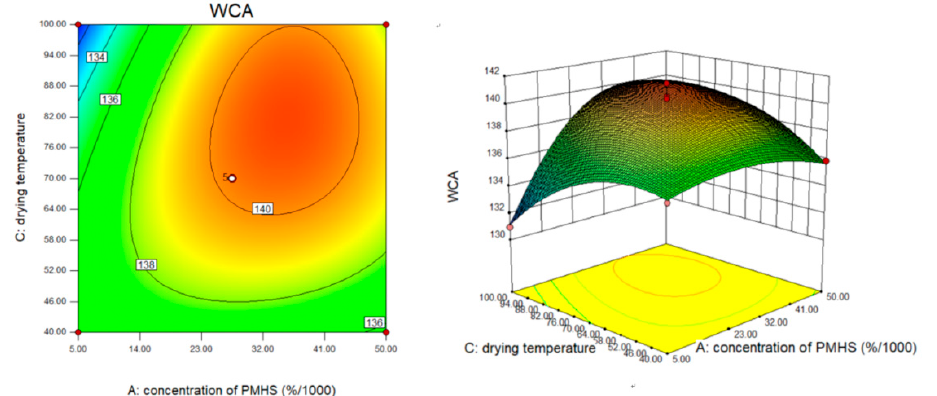
Figure 5. The effect of PMHS concentration and drying temperature.